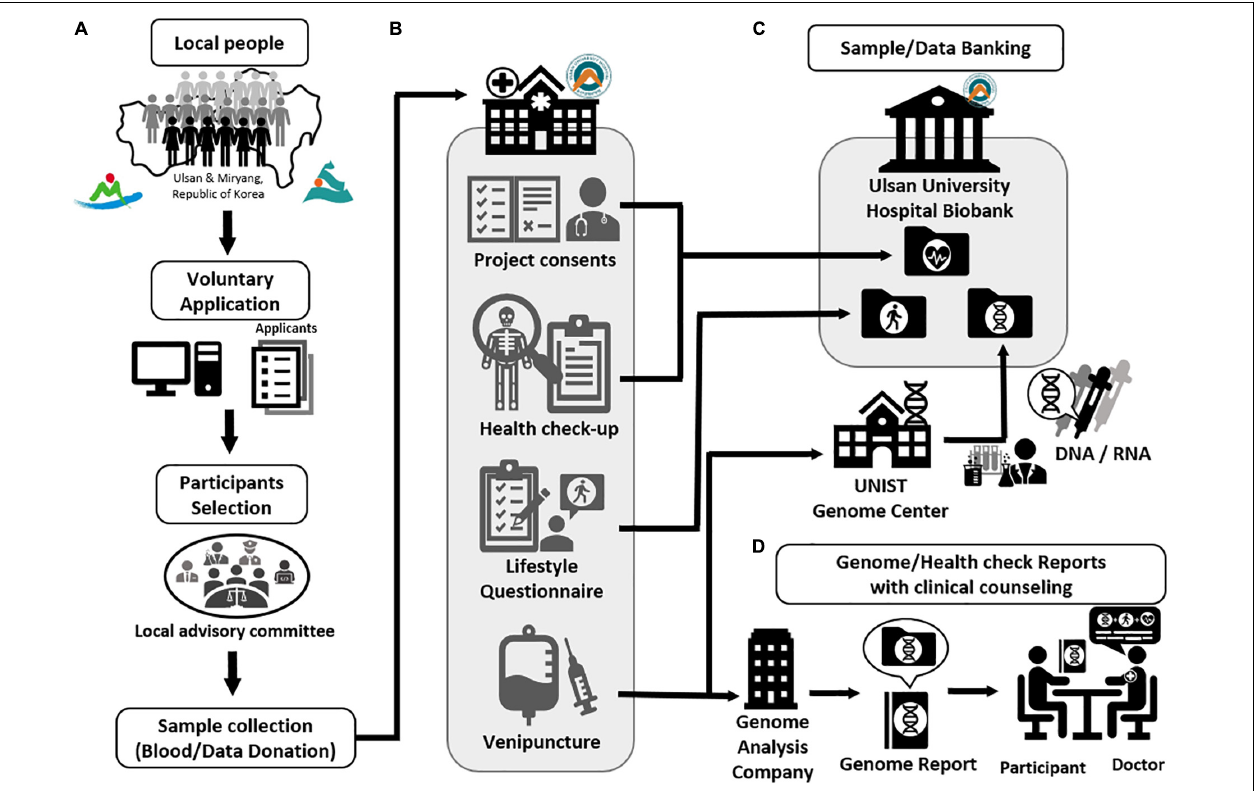
FIGURE 2 | The procedure of Welfare Genome Project. (A) Recruitment of participants. (B) Sample collection (Blood/Data donation) (C) Sample and data banking to Ulsan University Hospital Biobank. (D) Providing genetic and health check reports with clinical